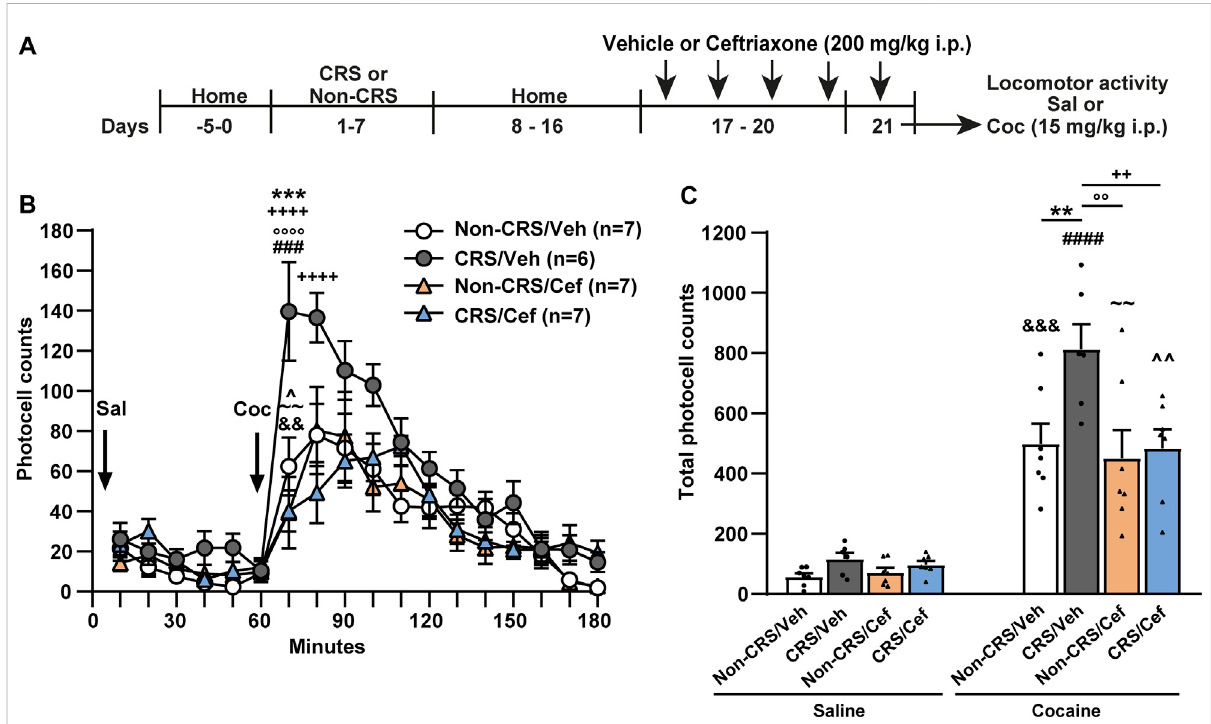
FIGURE 4 Ceftriaxone prevented the CRS-induced potentiation of locomotor response after acute cocaine administration. (A) Schematic timeline of the experimental protocol. (B) Time course of the horizontal photocell counts after saline and cocaine (15 mg/kg) i.p. injections. Time-frame from 10 to 60 min corresponds to saline administration at 0 min and time-frame from 70 to 180 min to cocaine administration. Three-way ANOVA with repeatedmeasuresovertimerevealedsigni fi cantinteraction(Non-CRSvs.CRSxVehvs.Cefxtime;F (17,391) =2.48, p < 0.01),signi fi canteffectof stress (Non-CRS vs. CRS; F (1,23) = 8.52, p < 0.01), ceftriaxone treatment (Veh vs. Cef; F (1,23) = 6.67, p < 0.05) and time (F (17,391) = 36.07, p < 0.0001). Bonferroni post-hoc testrevealed signi fi cant differences at 70 min (*** p < 0.001) when Non-CRS/Veh and CRS/Veh werecompared after a cocaine challenge. This multiple comparison test also showed signi fi cant differences at 70 and 80 min ( ++++ p < 0.0001) when CRS/Veh and CRS/Cef were compared after a cocaine i.p. injection. No differences among experimental groups were found after a saline i.p. injection (n.s.). Ceftriaxone treatment did not evidence a per se effect on motor activity as shown comparing Non-CRS/Cef with CRS/Veh at 70 min ( °°°° p < 0.0001) and Non- CRS/Cef with Non-CRS/Veh at any time (n.s.) in response to a cocaine challenge. No differences were found among experimental groups after a salinei.p.injection(n.s.).Thestimulatingeffectofcocaineonmotoractivitywasevaluatedineachexperimentalgroupcomparingdataat60 min(last data of horizontal motor activity after a saline i. p. injection) and 70 min ( fi rst data in response to a cocaine challenge). Two-tailed unpaired t -test revealed the psychomotor-stimulating effect of cocaine (Non-CRS/Veh: t 12 = 3.60; && p < 0.01 — CRS/Veh: t 10 = 5.11; ### p < 0.001 —